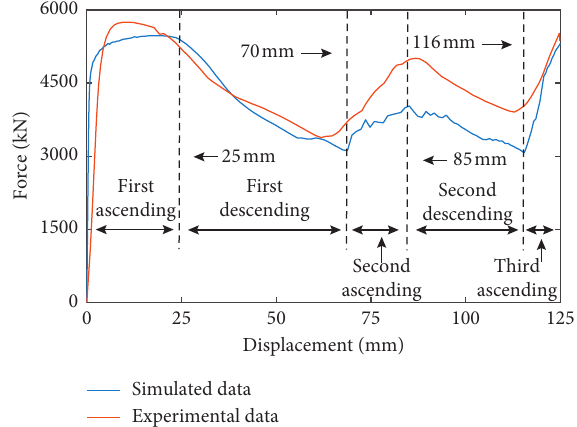
Figure 5: Comparison of numerical simulation and the test load- displacement